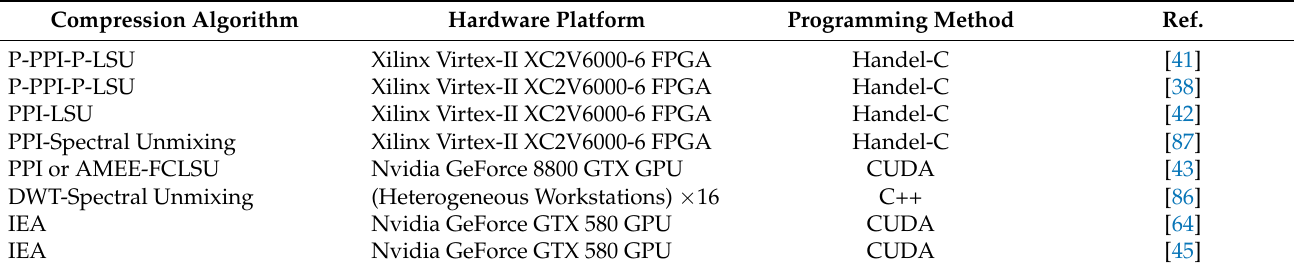
Table 5. List of studies on unmixing-based compression systems of hyperspectral images and their hardware